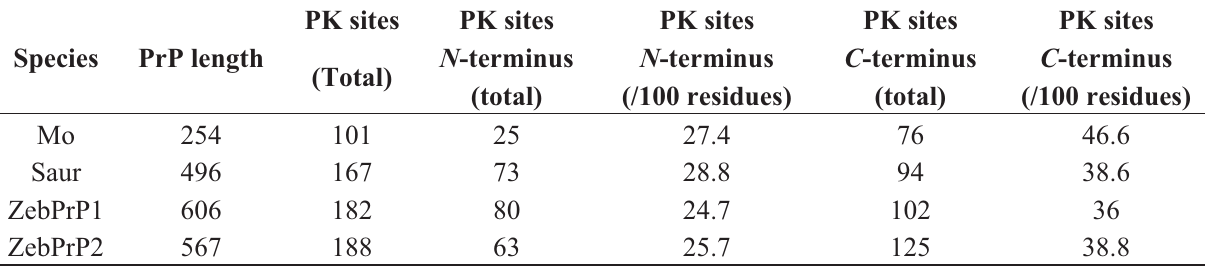
Table 1. Predicted PK target sites in the full-length sequences and along the N - and C -terminal regions of mouse (Mo), Sparus aurata (Saur), and zebrafish (ZebPrP1, ZebPrP2)